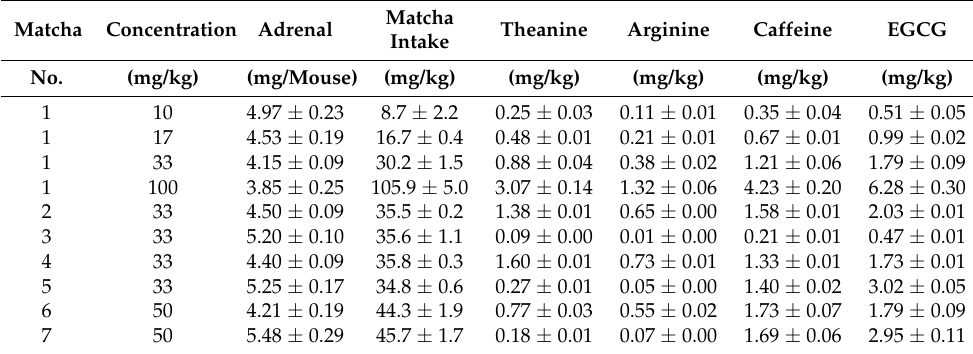
Table 3. Adrenal weight in mice that ingested each matcha sample, and the actual amount of each component that was ingested by mice.